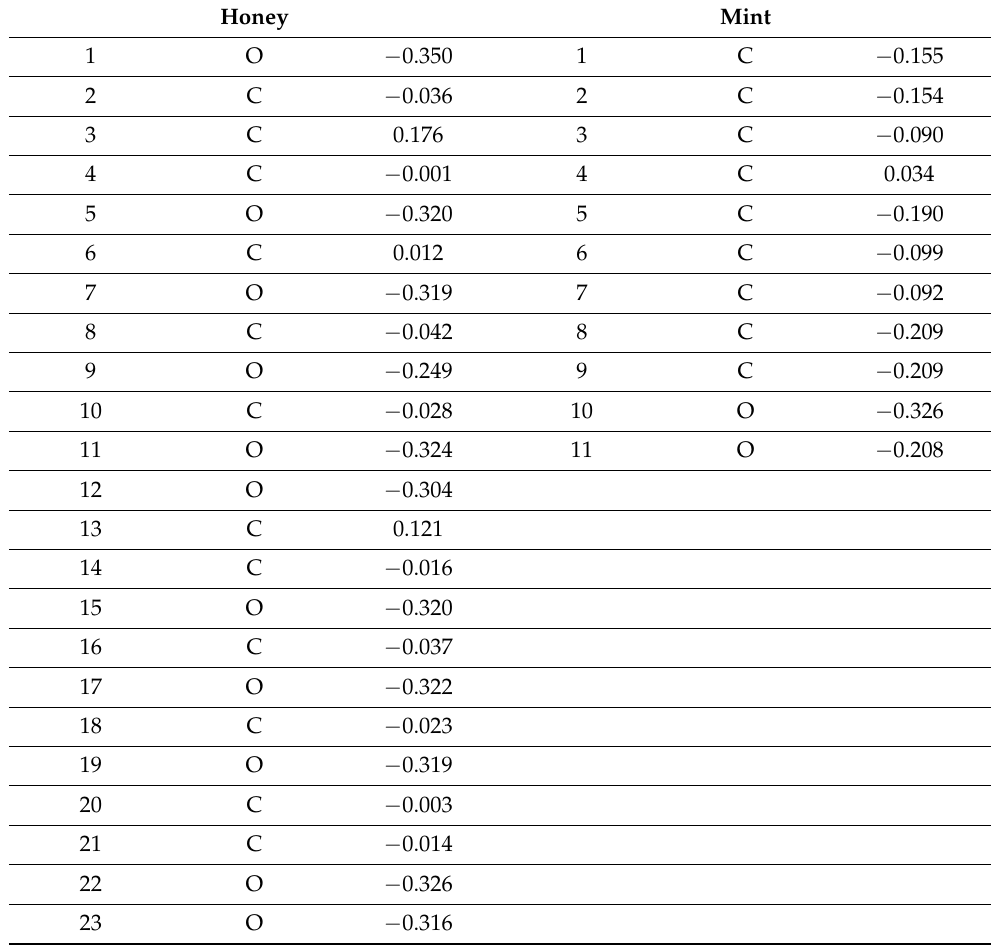
Table 2. Mulliken atomic charges of honey and mint by